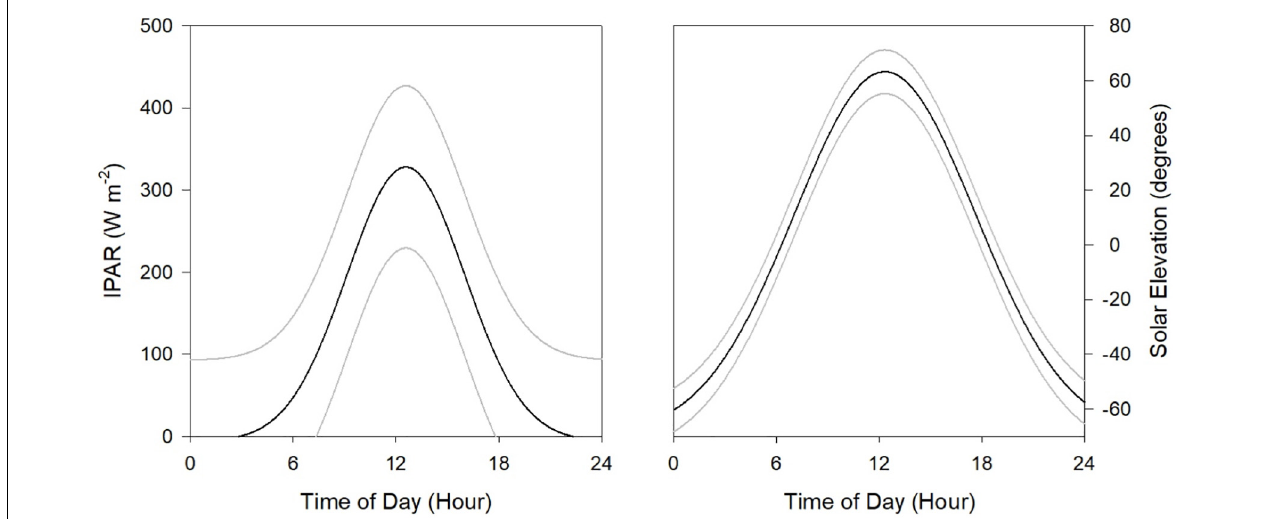
FIGURE 2 | Estimated mean (black line) and 95% confidence intervals (gray lines) of light intensity at 5 m depth ( IPAR 5 m , left panel ) and solar elevation (right panel) across the four surveys conducted in the northern GoM during 2015 and